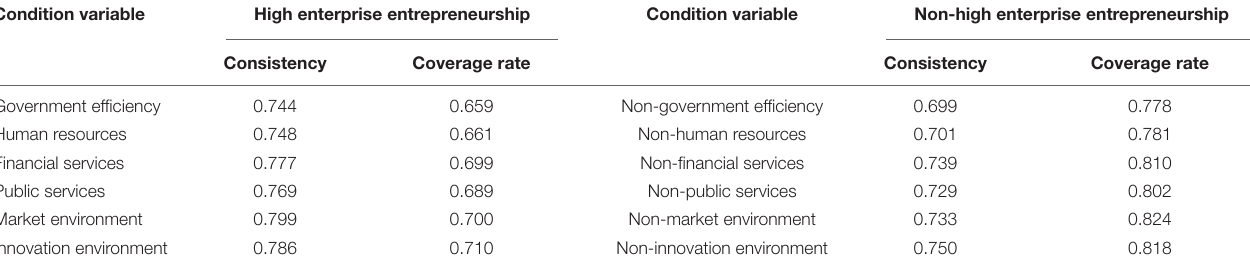
TABLE 5 | Necessity test of single